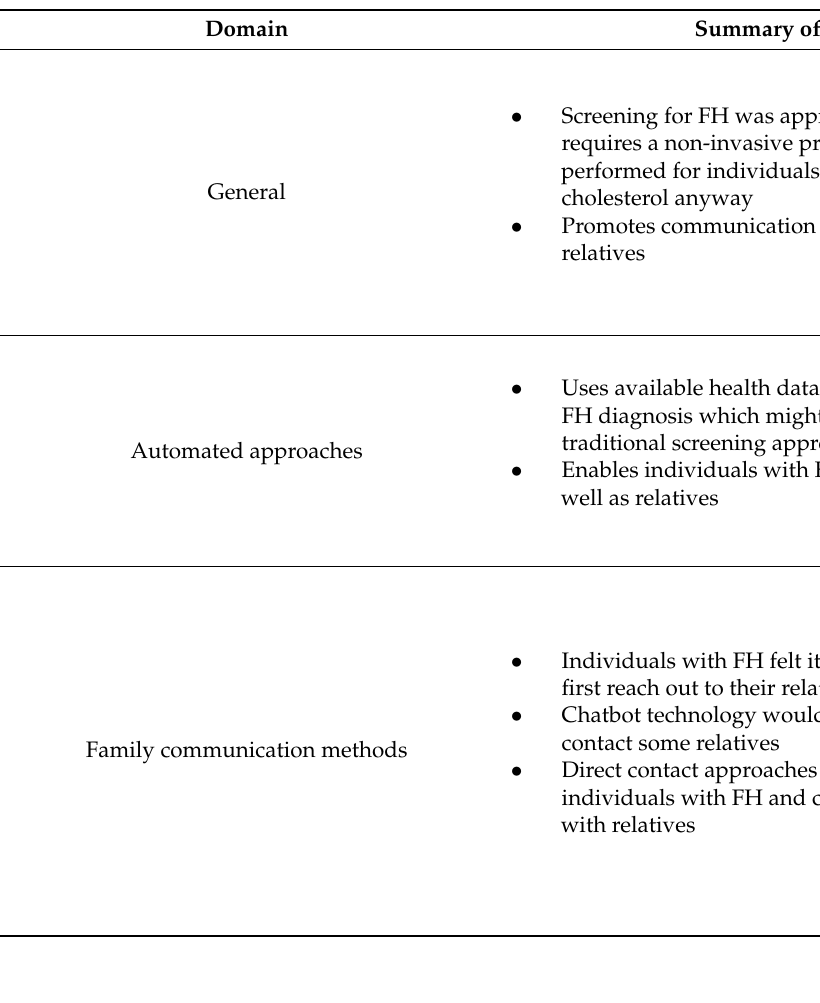
Table 4. Key points with exemplar quotes related to general appropriateness and specific appropriateness related to automated screening approaches and family communication